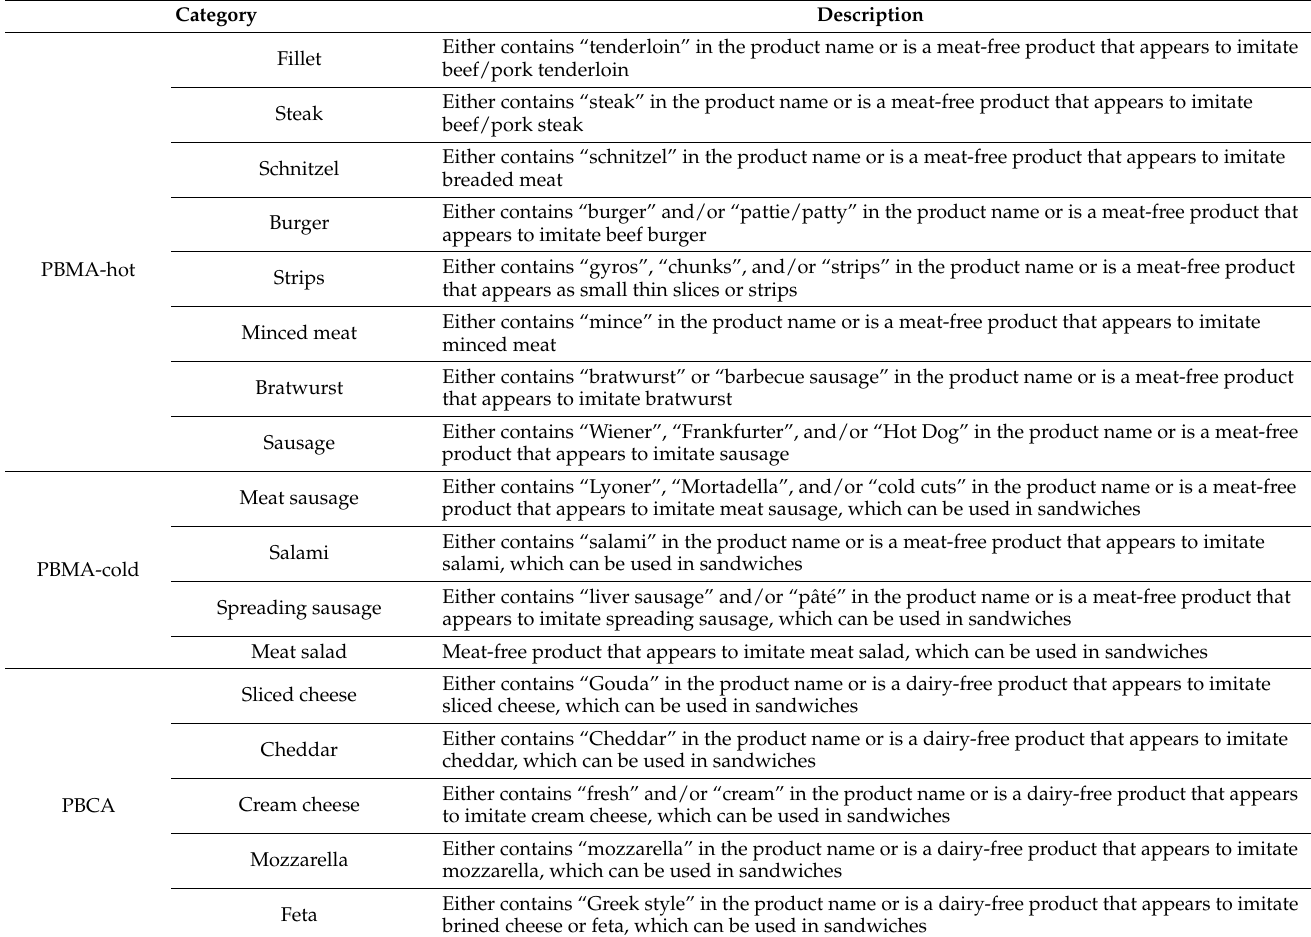
Table 1. Classification of pb alternative product